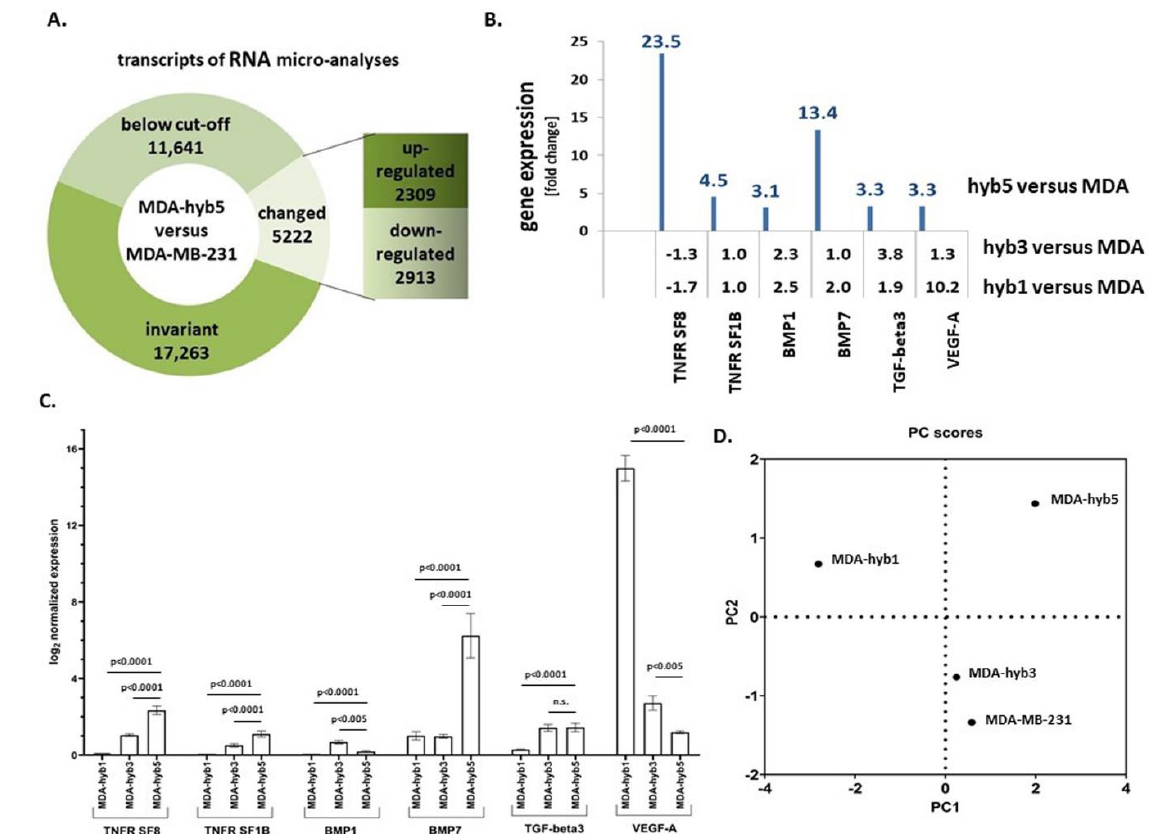
Figure 5. ( A ) RNA microarray analysis of 34,126 transcripts was performed in MDA-hyb5 cells as compared to the parental MDA-MB-231 cells. Changes in transcript levels below 2-fold were considered below cut-off. ( B ) Analysis of the RNA microarray data was performed with a focus on the expression of dormancy-associated genes (tumor necrosis factor receptor superfamily member 8 (TNFR SF8); tumor necrosis factor receptor superfamily member 1B (TNFR SF1B); bone morphogenic protein1 (BMP1); bone morphogenic protein7 (BMP7); transforming growth factor-beta3 (TGF-beta3); vascular endothelial growth factor-A (VEGF-A)). Differences in fold changes are indicated for the relationship of gene expression in MDA-MSC-hyb5 (hyb5), MDA-MSC-hyb3 (hyb3), and MDA-MSC-hyb1 (hyb1) cells versus the parental MDA-MB-231 (MDA) cells, respectively. ( C ) Gene expression levels were normalized to GAPDH and RPL13A by qPCR. Data represents the mean + SEM of the corrected expression levels ( n = 4) and significance ( p ) was calculated by the Dunnett’s mul- tiple comparison ANOVA test (ns = not significant). ( D ) A scattered plot of principal components (PC) was generated by GraphPad Prism v9.00 and demonstrated the differences between the cell lines according to the genes analyzed.